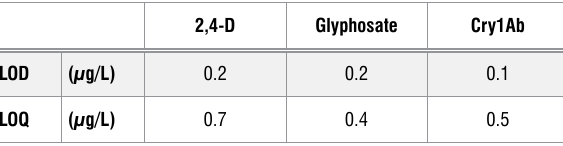
Table 2: Limit of detection (LOD) and limit of quantification (LOQ) values for each of the target